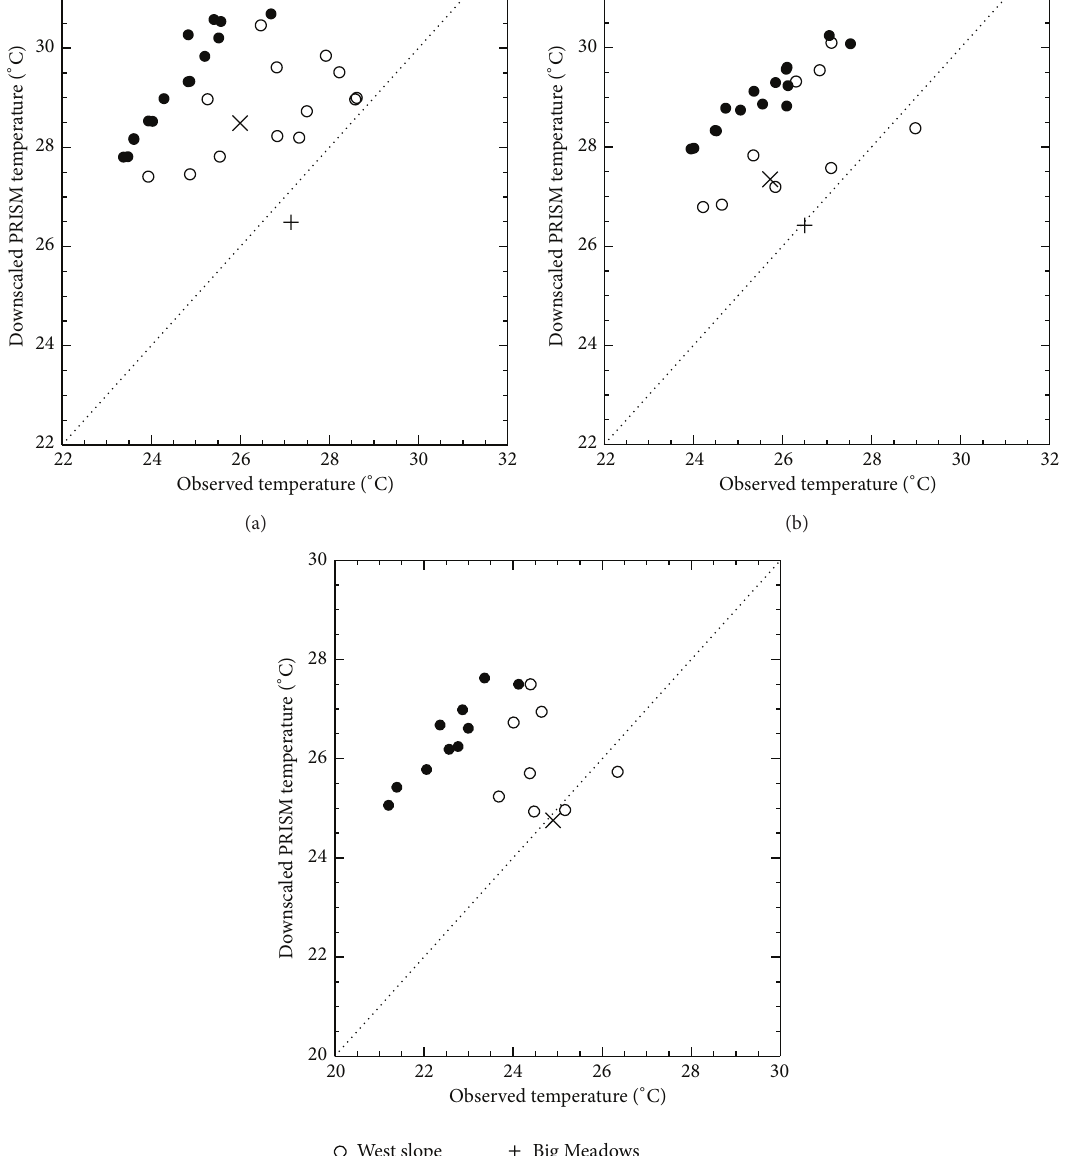
There are also differences in mean July 𝑇 max between the sensor pairs deployed at different azimuths along the east slope, with mean July 𝑇 max along the southeast-facing slopes on average 0.5 ∘ C higher than the northeast-facing slopes. These differences are lower than those reported in